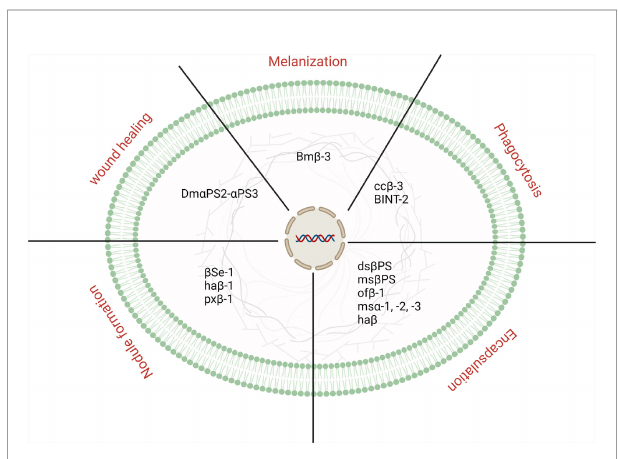
FIGURE 1 | An overview is representing different physiological processes controlled by integrins in